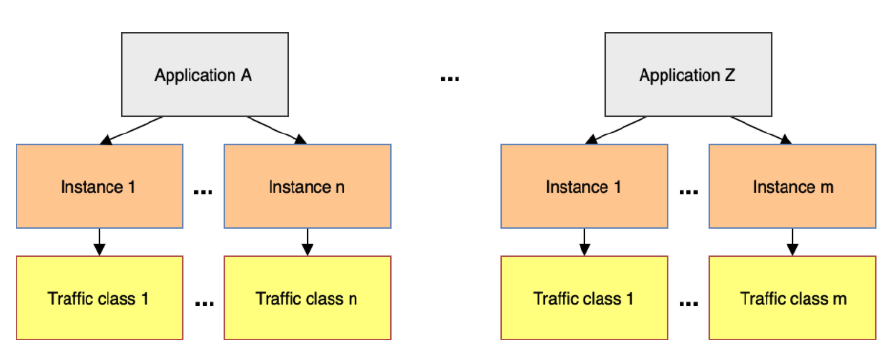
Figure 2. Relationship diagram between applications, instances, and traffic classes.